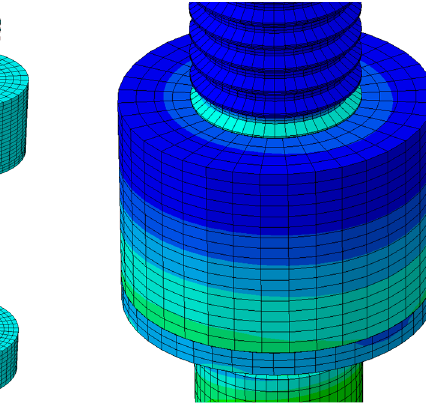
Figure 8. Development of FE models using ABAQUS.